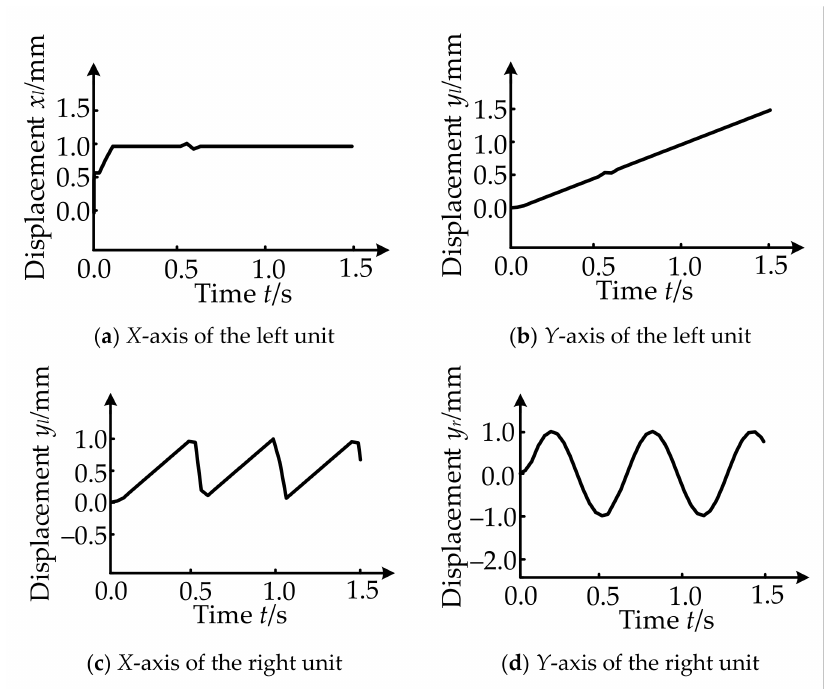
Figure 13. Displacement of the rotor under the input signal. It can be seen from Figure 13 that after different input signals are input into different channels, the corresponding channels can produce relative output changes which have a slight influence on the remaining channels. In other words, the decoupling between the displacement changes and the input signals of the multi-DOF system of the MLDSB can be achieved. The block diagram after adding displacement feedback is shown in Figure